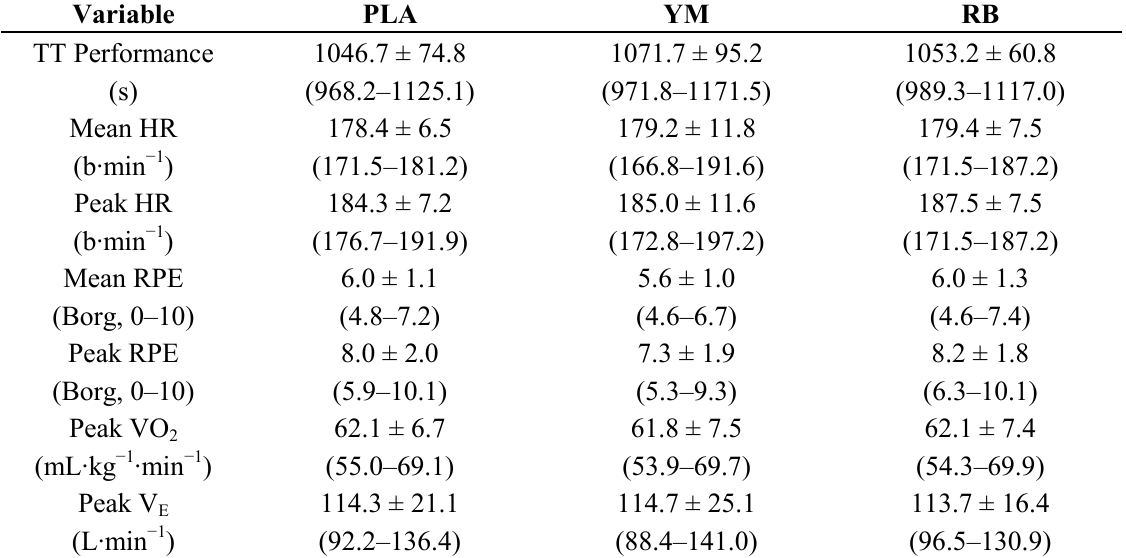
Table 3. Mean ± SD and 95% Confidence Intervals for time-trial performance and